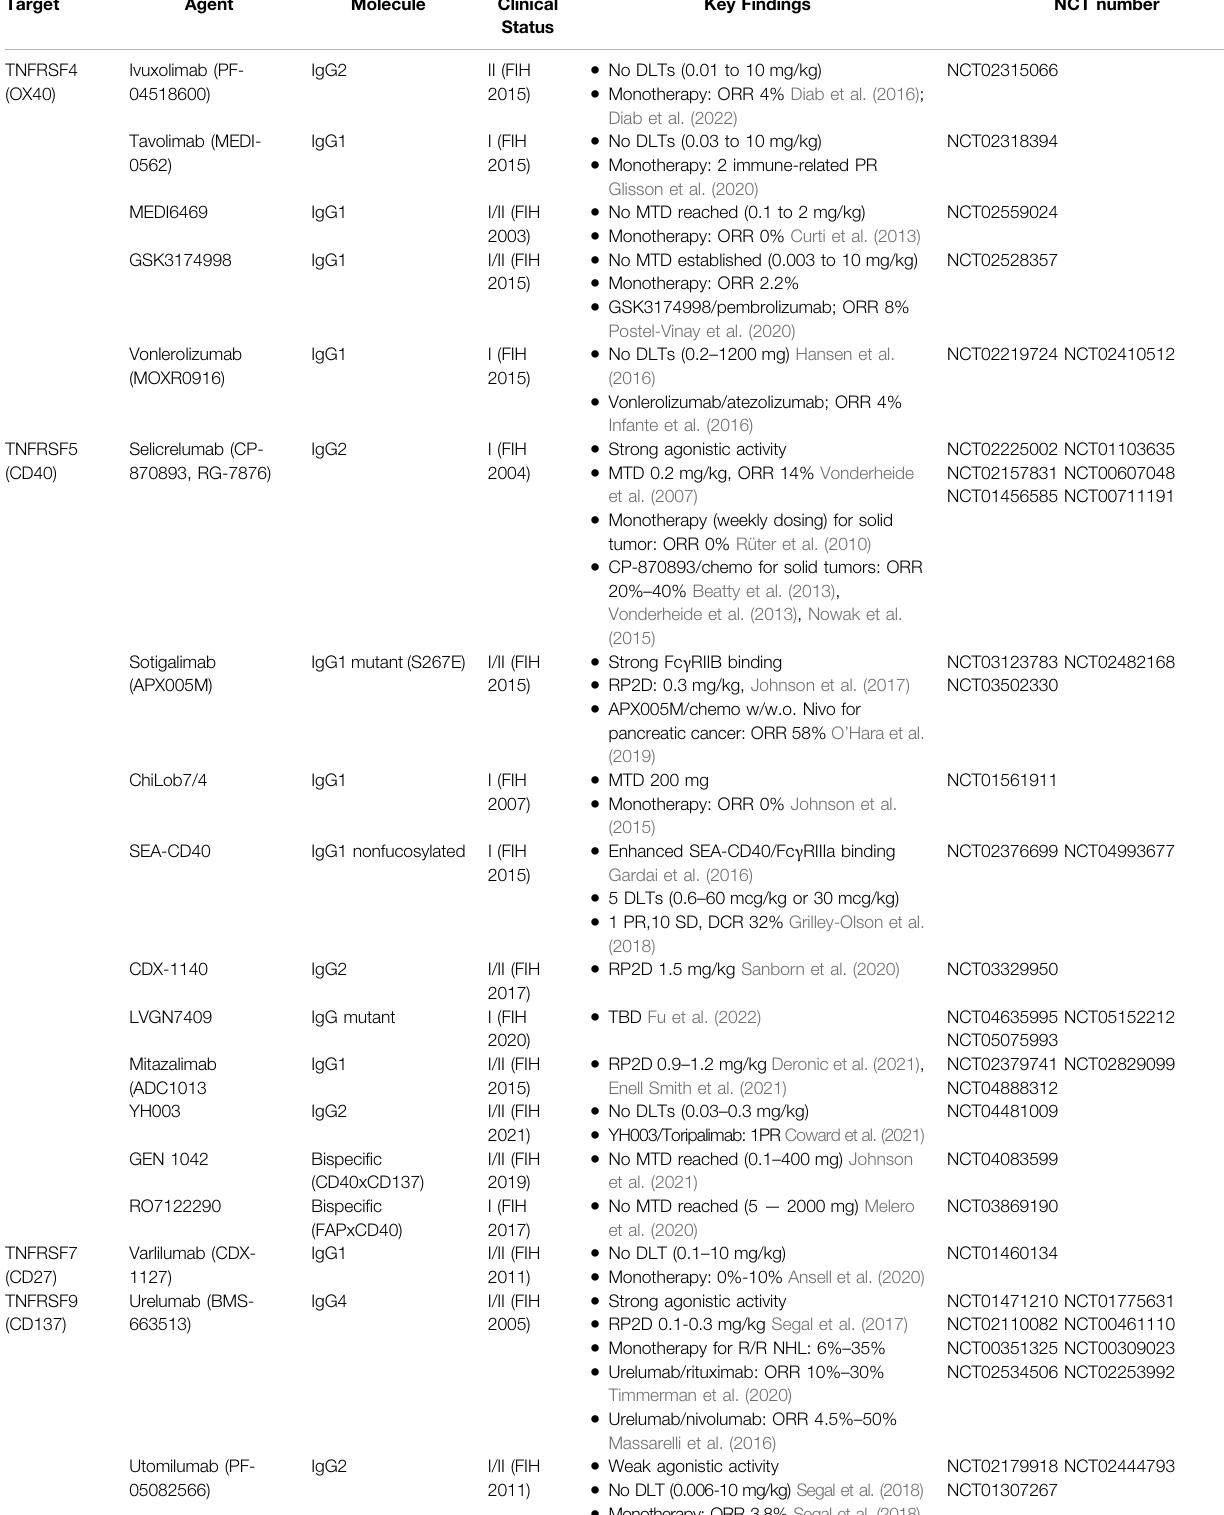
TABLE 2 | Clinical studies of anti-TNFRSF agonistic antibodies for cancer treatment, alone or in combination.